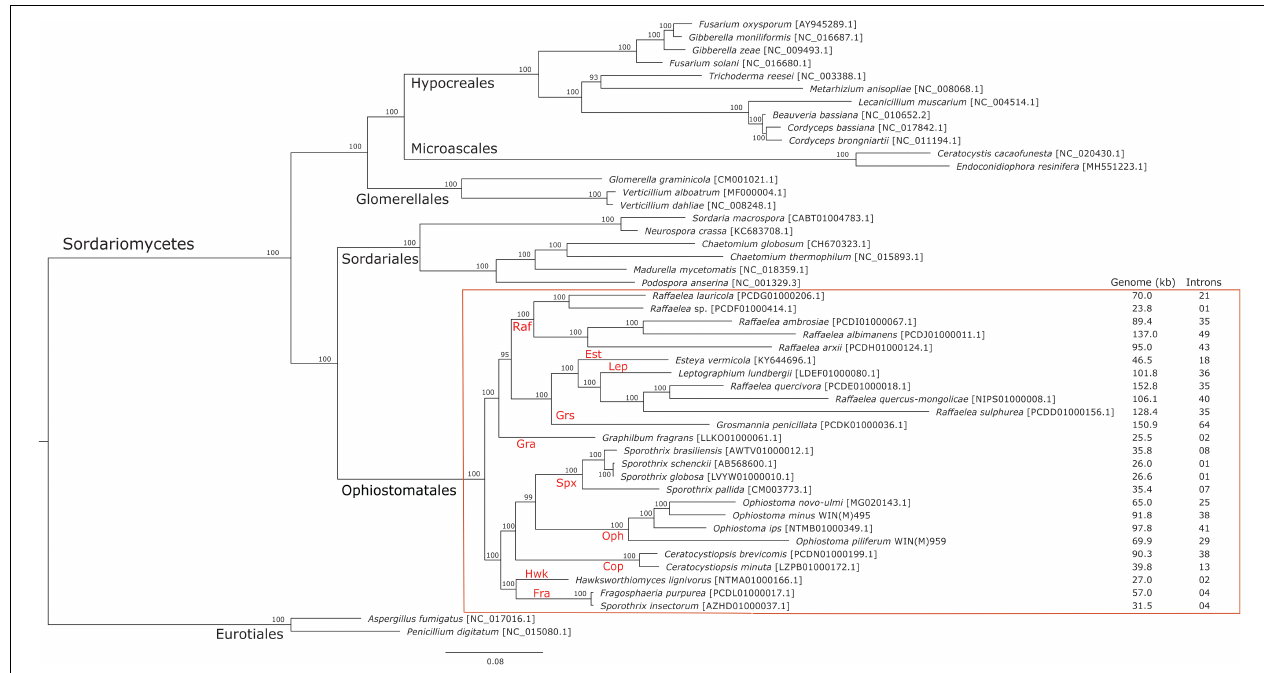
FIGURE 5 | Phylogenetic tree of mitogenomes showing the position of Ophiostoma minus and Ophiostoma piliferum among members of the Ophiostomatales. The tree topology (50% majority-rule consensus tree) was generated by the MrBayes program and involved 48 concatenated amino acid sequences. The tree is drawn to scale with branch length measured in the number of substitutions per site. Posterior probability values are indicated at the nodes. NCBI and GenBank accession numbers (except for Verticillium alboatrum, which refers to MitoFun database) are indicated in square brackets. For the members of the Ophiostomatales, mitogenome sizes, and total numbers of introns are listed for each genome. Taxonomic designations (Orders, and Genera for the Ophiostomatales) are indicated on the relevant branches. Raf, Raffaelea ; Gra, Graphilbum ; Est, Esteya ; Grs, Grosmannia ; Lep, Leptographium ; Spx, Sporothrix sensu stricto ; Cop, Ceratocystiopsis ; Oph, Ophiostoma sensu stricto ; Hwk, Hawksworthiomyces ; Fra, Fragosphaeria .